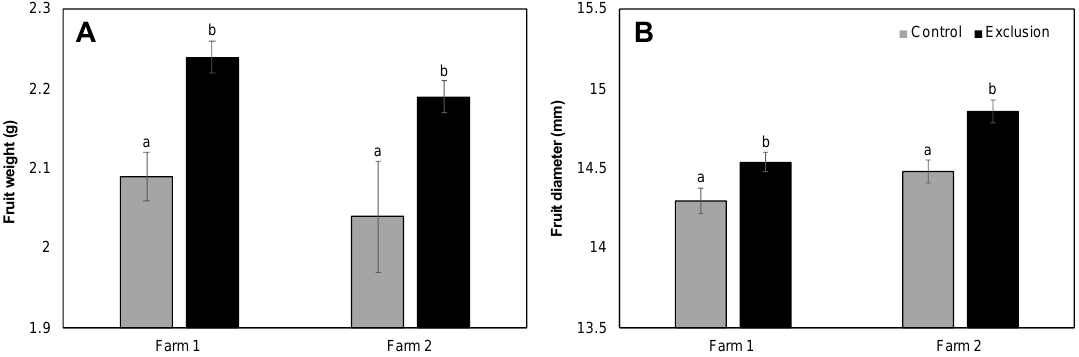
Figure 6. Mean (± SE) weight ( A ) and diameter ( B ) of ripe coffee fruits harvested from 20 trees per treatment (un-netted control and netted exclusion) at two farms on Hawai’i Island (Farm 1: 279 m, var. catuai , Farm 2: 393 m, var. typica ). Lowercase letters represent significant differences in the means.